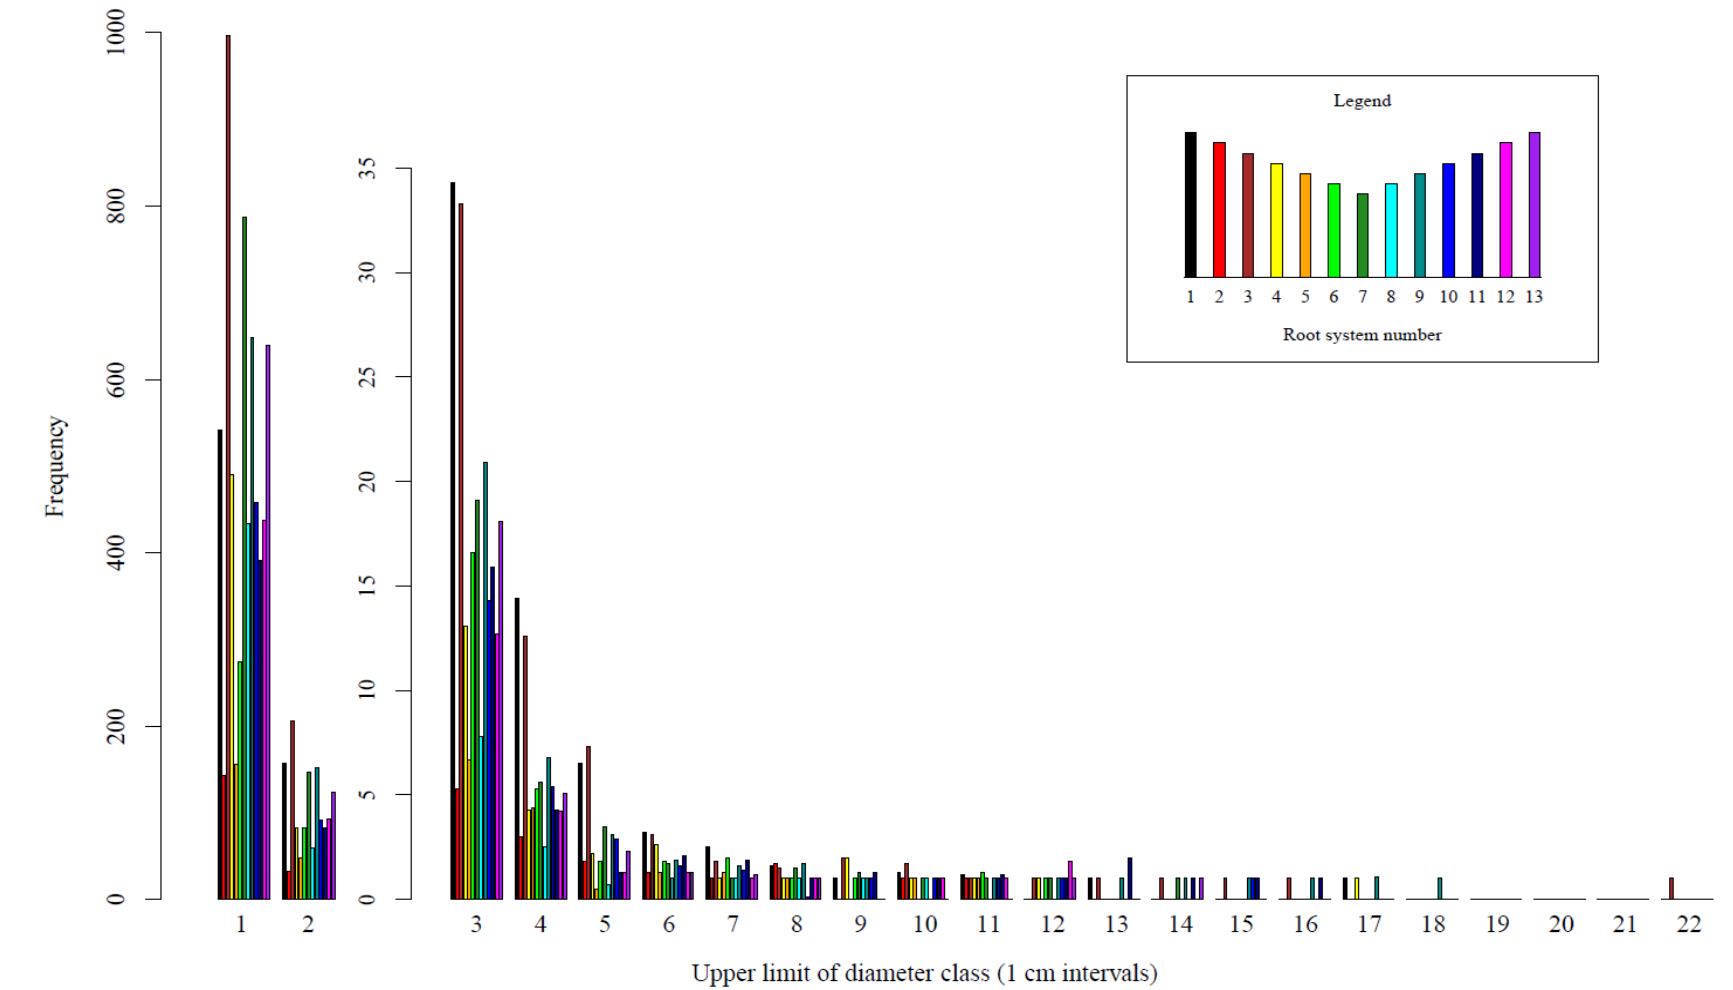
Figure 8. Frequency of root breakpoint diameters. Each colored bar represents the mean frequency values in each diameter class for 15 model fits of an individual root system. The same dataset is presented at two different scales to improve legibility within each diameter